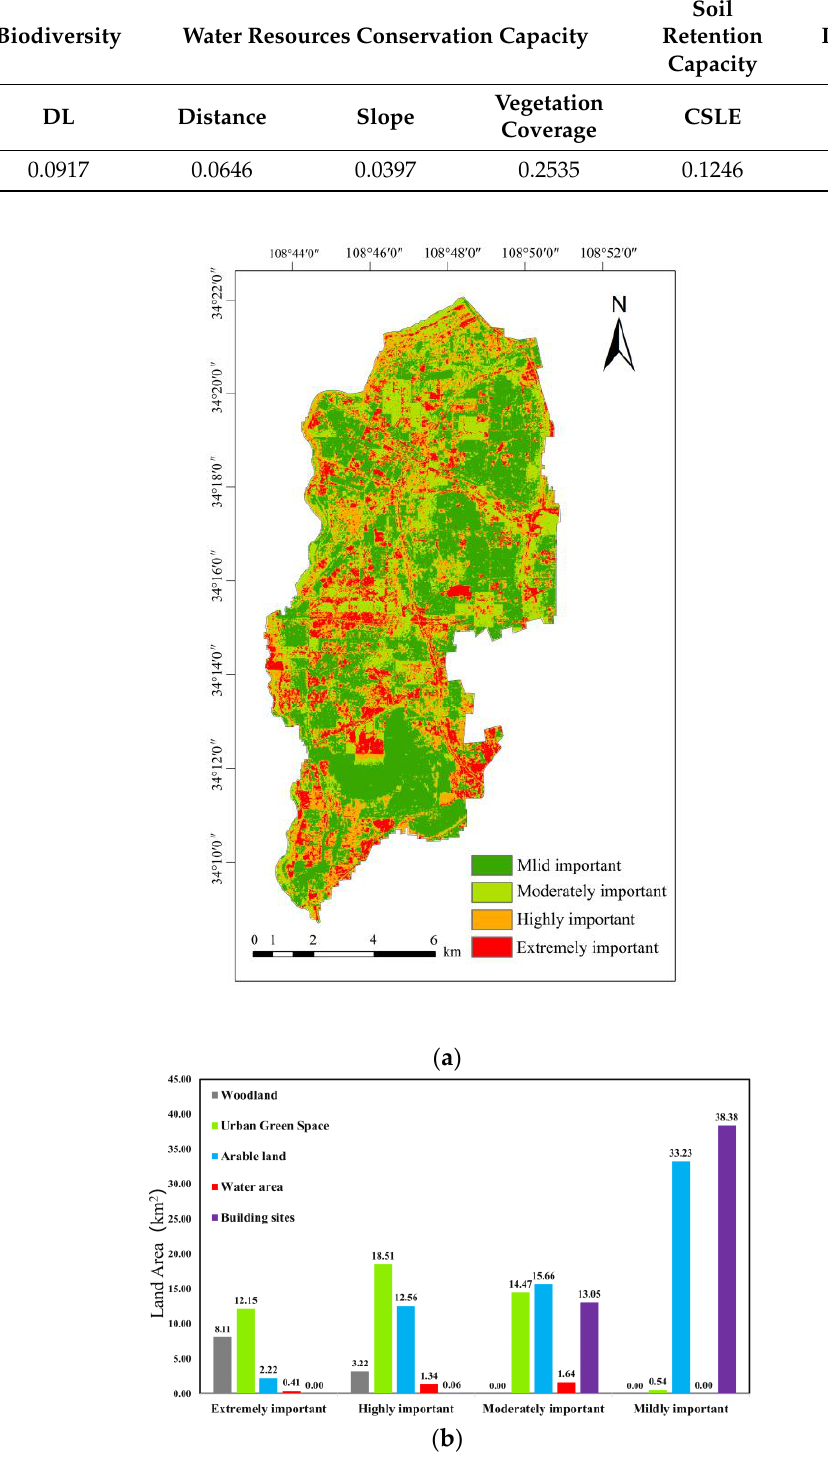
Figure 8. Evaluation of ecological land importance. ( a ) Evaluation results of ecological land importance; ( b ) land analysis.